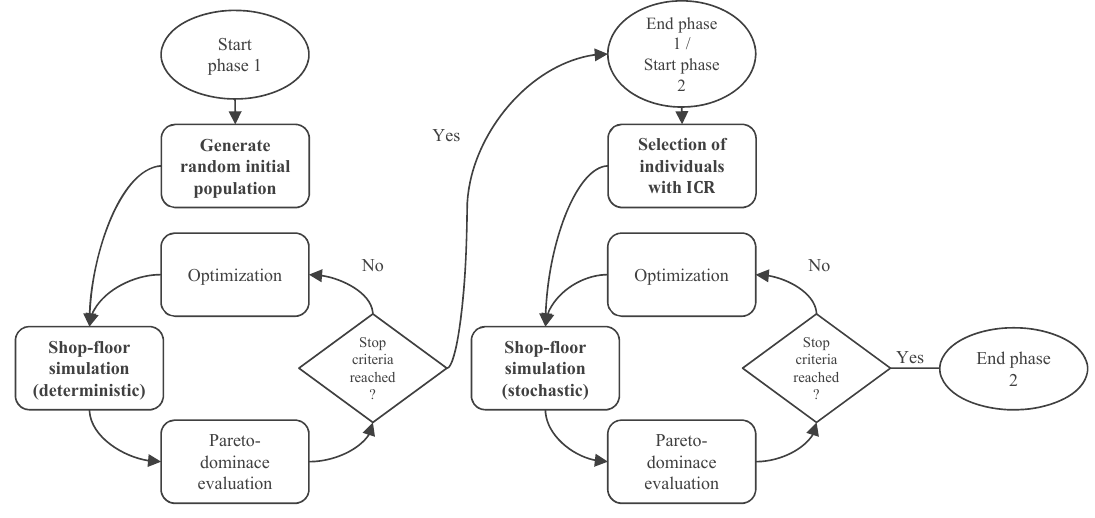
Figure 3. Two-phase genetic